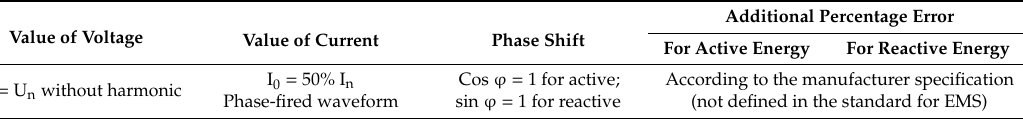
Value of Current Phase Shift